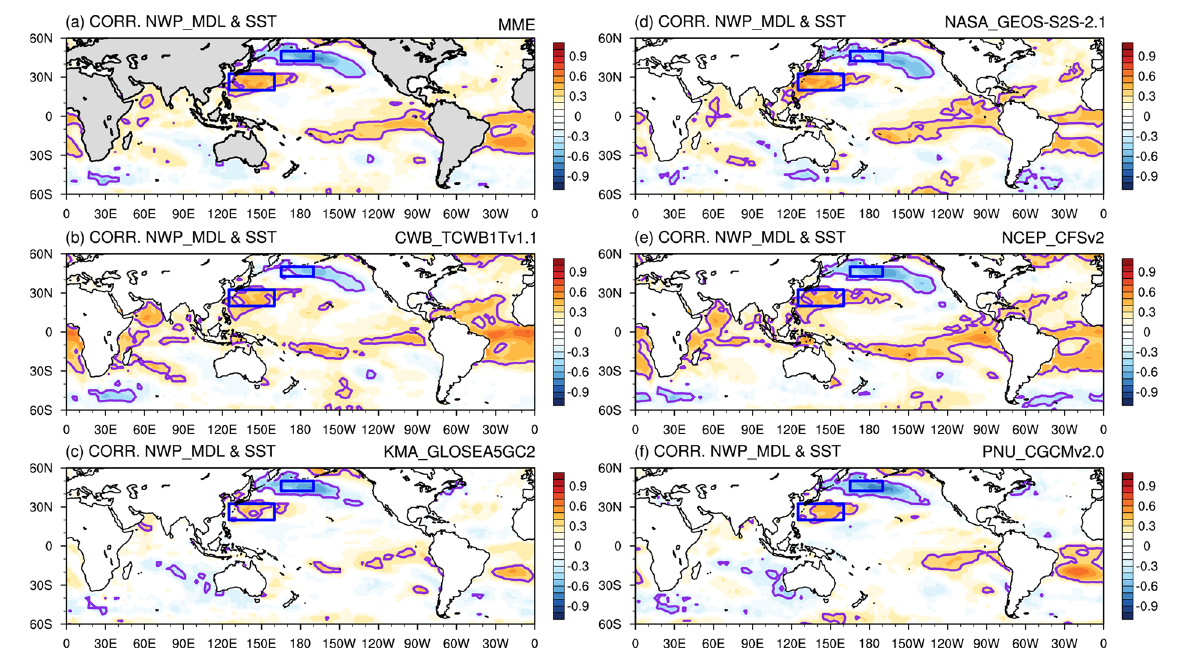
Figure 10. The correlation pattern between SST and the NWP index predicted by ( a ) MME and ( b – f ) individual model NWP index. Blue boxes enclose the areas of SST averaging used for the estimation of the NWP index. Significant at the 95% confidence level values are enclosed by a thick line.